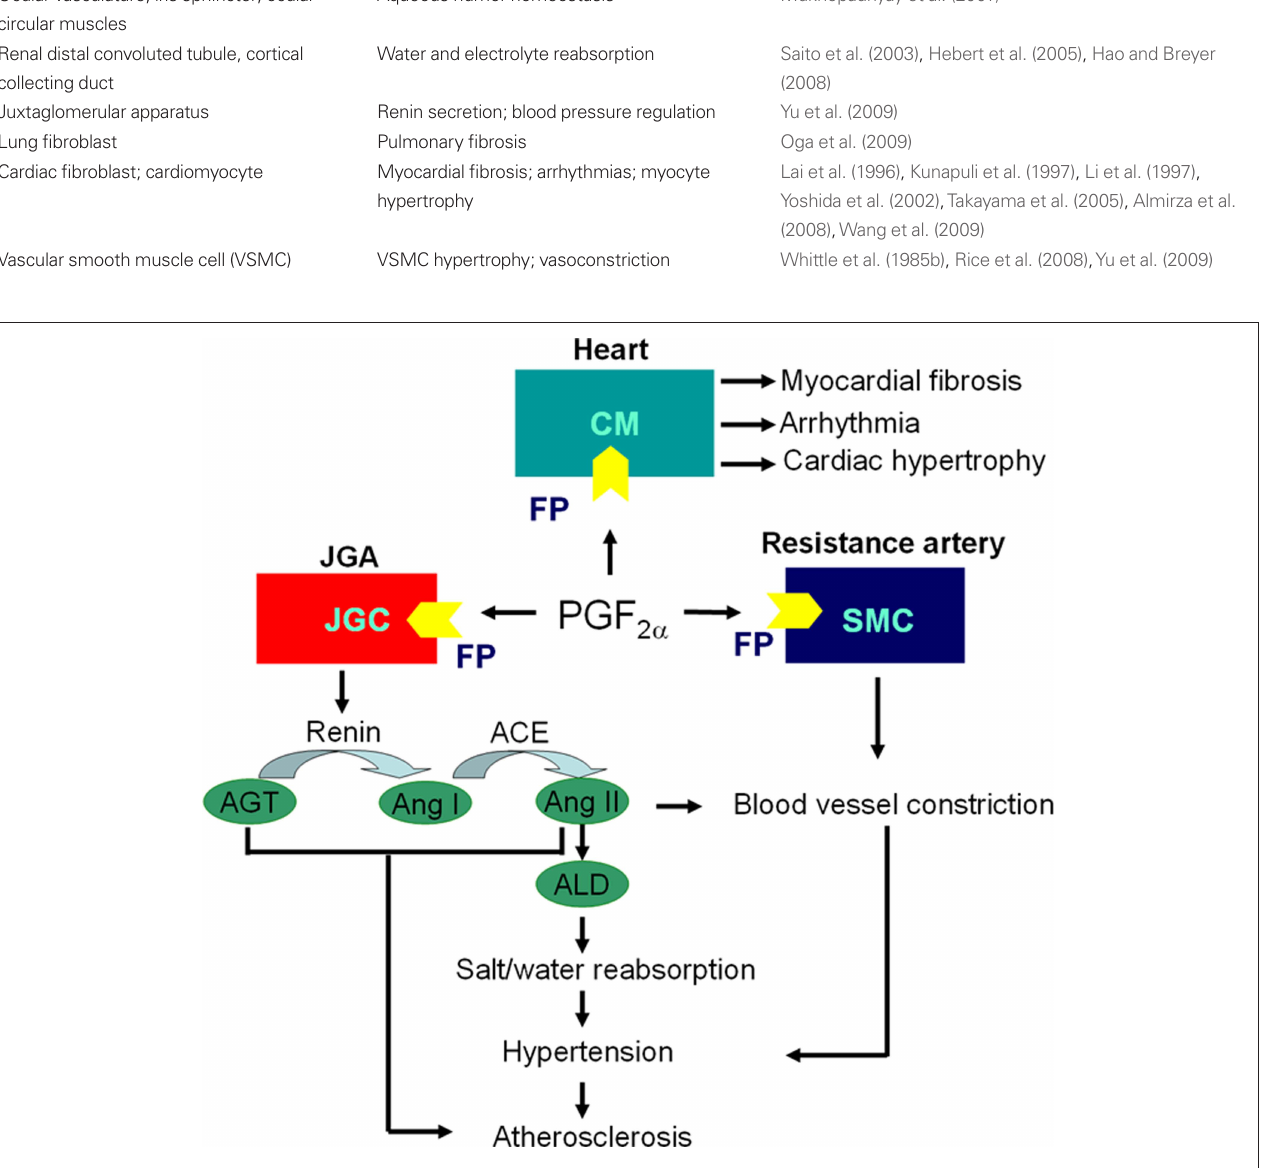
Figure 2 | Scheme of PgF /FP pathway involved in pathogenesis of 2 α cardiovascular disease. Cardiac fibroblasts derived PGF induces cardiac 2 α hypertrophy, fibrosis and arrhythmia through FP receptor in adjacent cardiomyocytes (CMs); PGF stimulates renin release from juxtaglomerular 2 α granular cells (JGCs) by FP receptor in an autocrine fashion, and activate renin–angiotensin–aldosterone system (RAAS) to elevate blood pressure